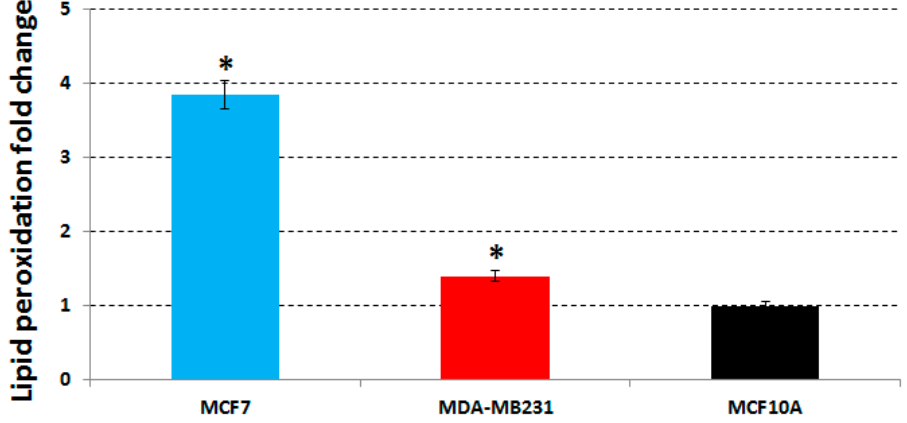
Figure 3. Evaluation of the lipid peroxidation. We show the changes in the expression levels of lipid peroxidation of MCF7 (in cyan), MDA-MB231 (in red) and MCF10A (in black) cell lines treated at concentrations of 63 µ g/mL, 64.5 µ g/mL and 64.5 µ g/mL of phenolic extract compared to those of untreated cells. Data are reported as the mean value plus/minus the standard deviation. Statistically significant differences between treated and untreated samples are indicated by *.